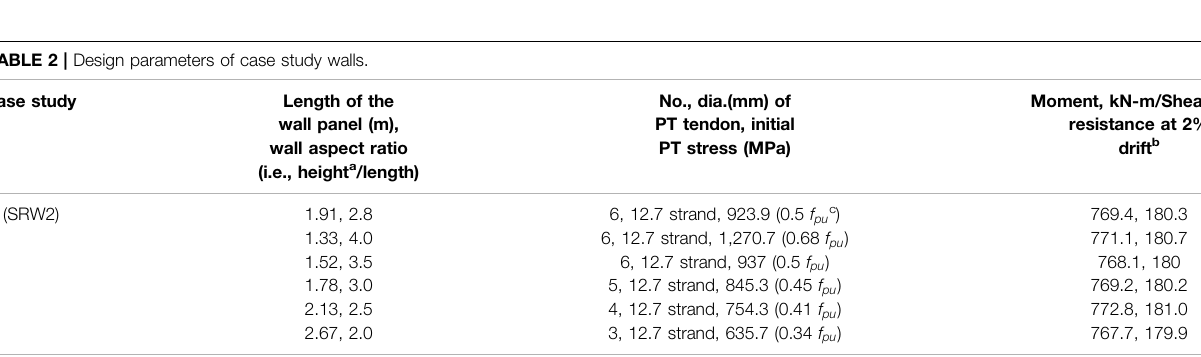
TABLE 2 | Design parameters of case study